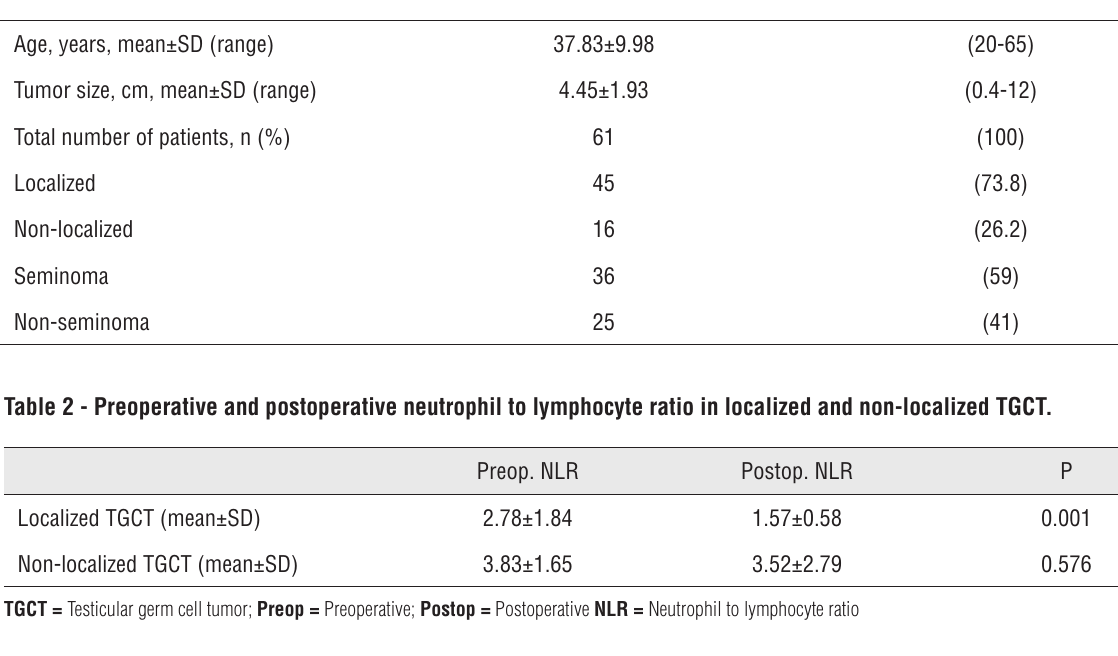
Table 1 - Demographic characteristics of the patients.